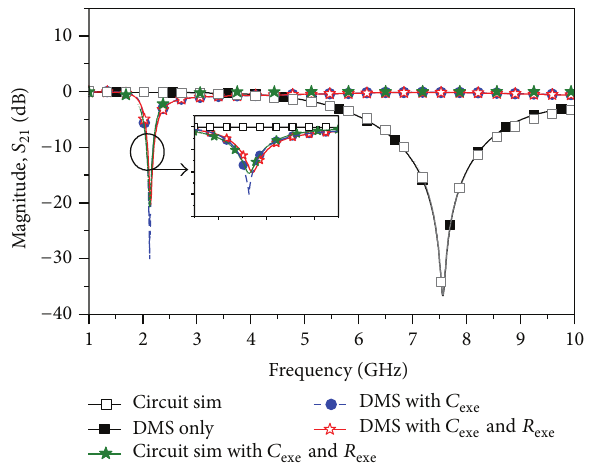
Figure 2: Full-wave and circuit simulated transmission response of U-shaped DMS with external lumped elements.